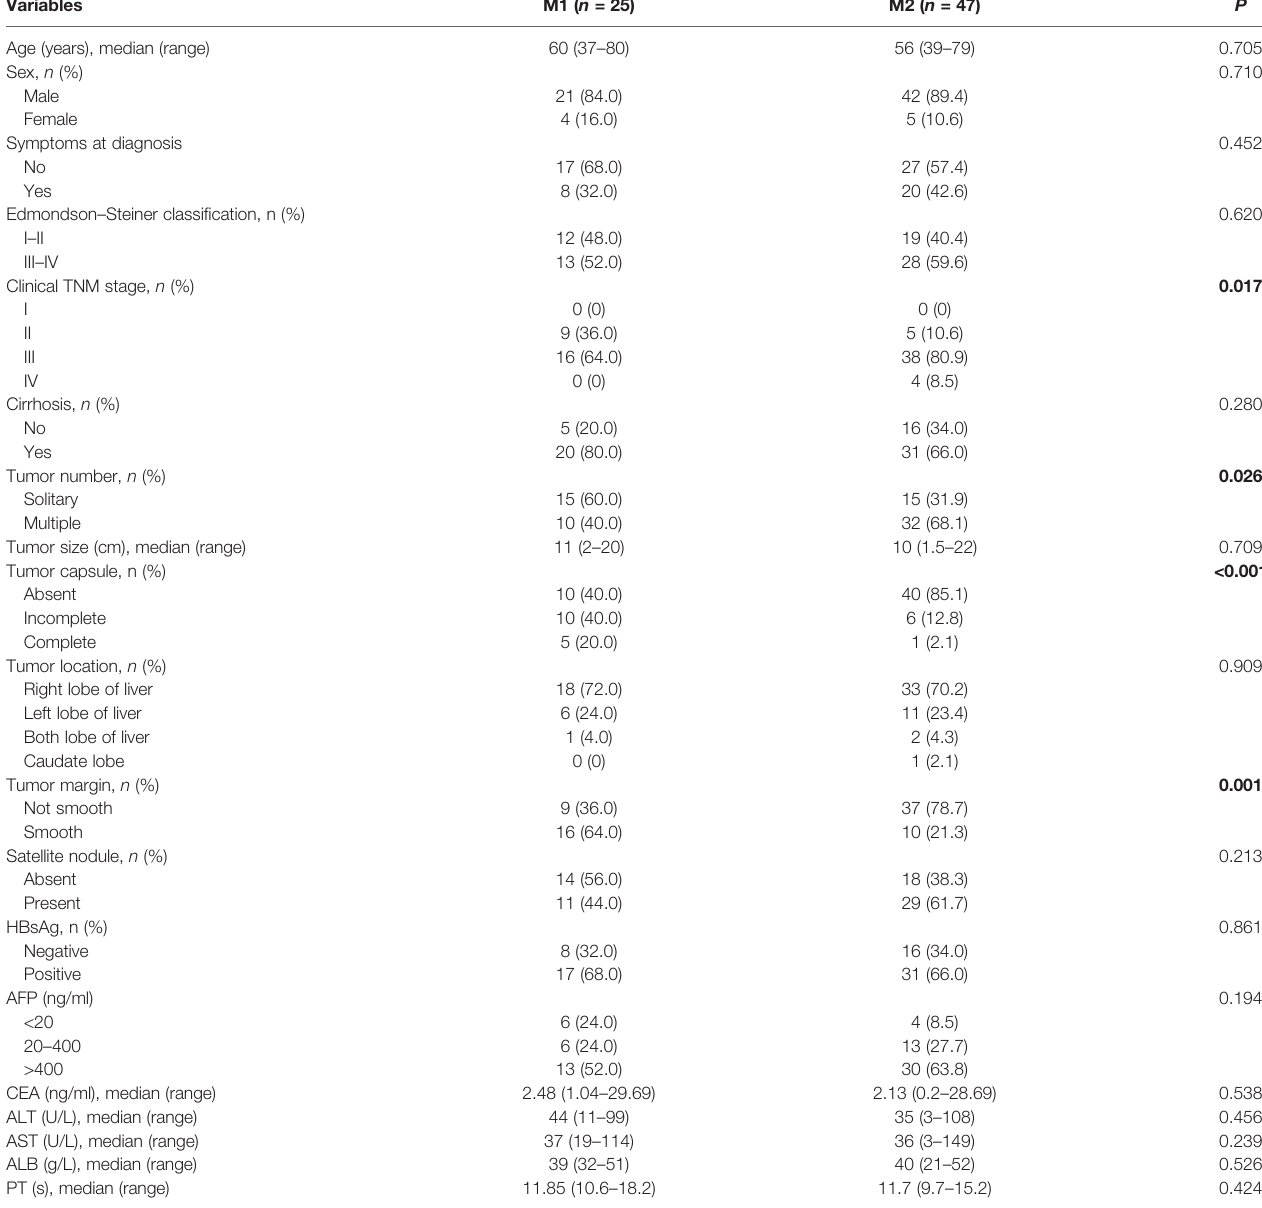
TABLE 2 | Clinical characteristics comparison in HCC patients with different degrees of MVI. Variables M1 ( n = 25) Age (years), median